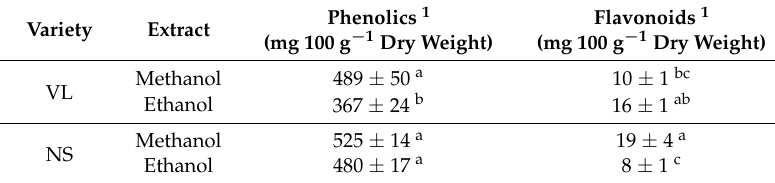
Table 2. Concentration of phenolics and flavonoids in extracts of fruit from Sechium edule var . virens levis (VL) and S. edule var . nigrum spinosum